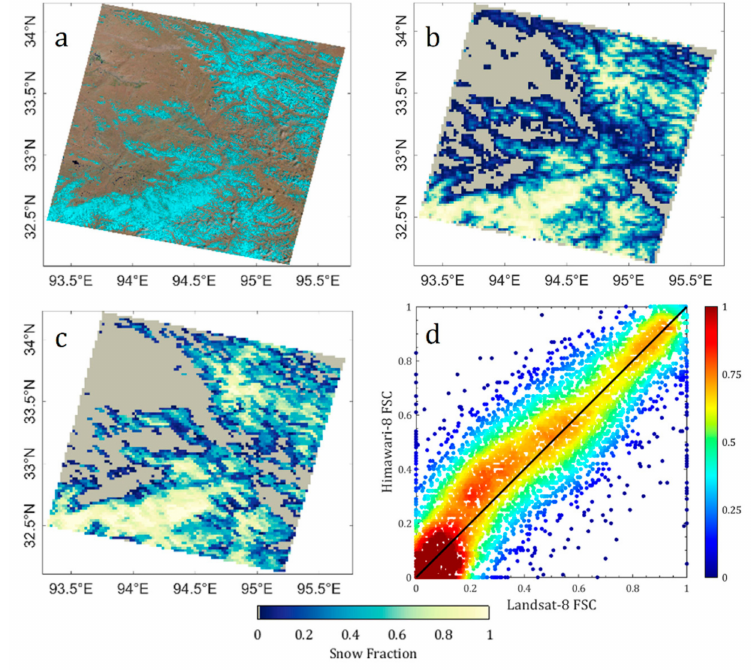
Figure 7. A case evaluation of Himawari–8 AHI fractional snow cover with Landsat–8 data for grassland: ( a ) Landsat–8 OLI image at the Worldwide Reference System-2 (WRS-2) Path / Row of 136 / 037 on 22 October 2016; ( b ) the corresponding Landsat–8 OLI fractional snow cover; ( c ) the corresponding Himawari–8 AHI fractional snow cover at UTC 4:10 a.m.; ( d ) the scatter plot displaying 8765 points of Himawari–8 AHI fractional snow cover versus Landsat–8 fractional snow cover at a 0.02 ◦